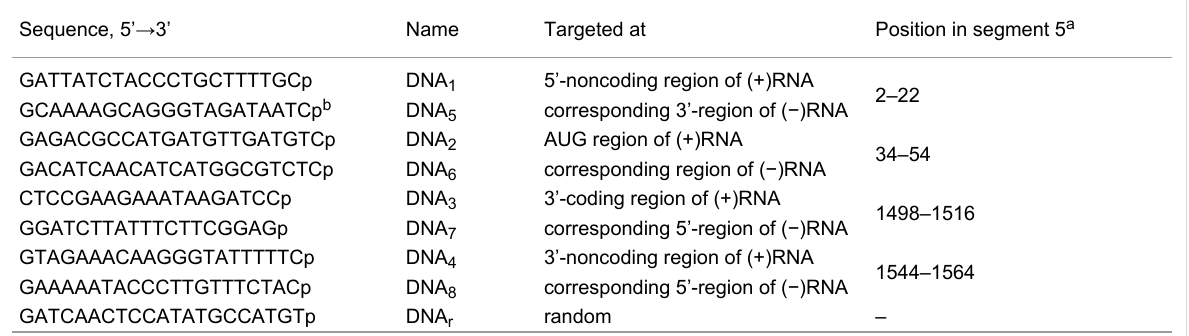
Table 1: Oligonucleotides aimed at different regions of influenza A virus segment 5. Sequence, 5’ → 3’